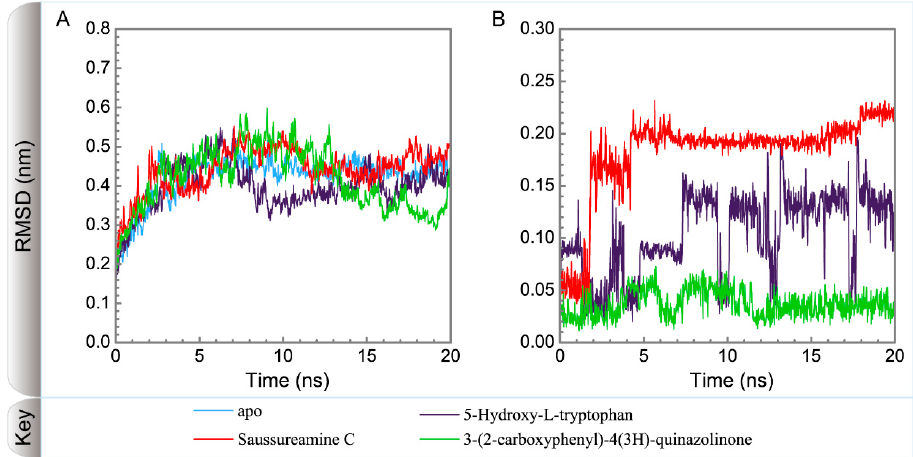
Figure 5. Variation of root-mean-square deviations, of ( A ) protein and ( B ) ligand over 20 ns for paraplegin in apo form and in complexes with three TCM candidates.